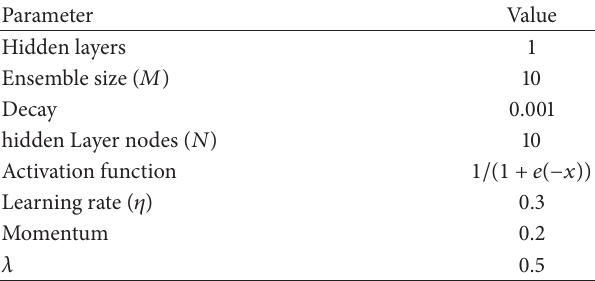
Table 4: Selected ensemble of MLP using NCL parameters based on 5-fold cross